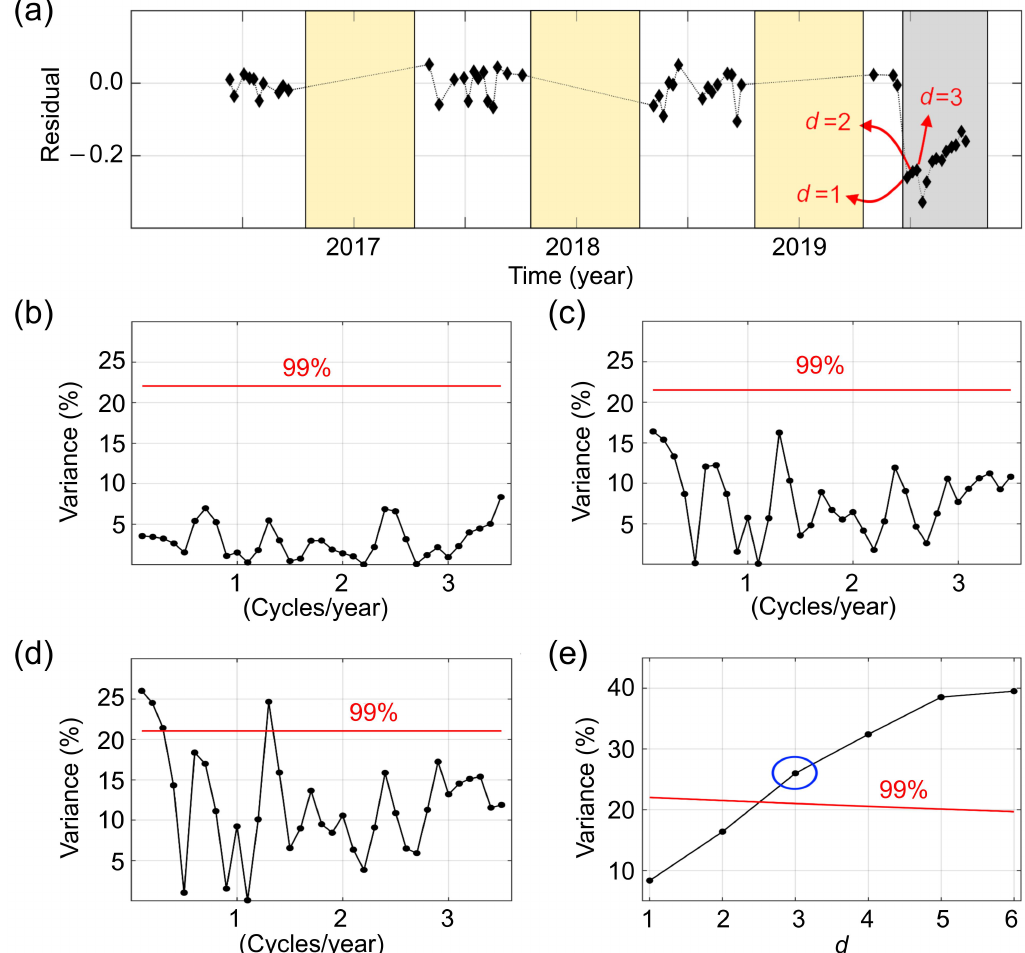
Figure 5. An example of the near-real-time disturbance detection from the residual series. ( a ) the residual series of the time series shown in Figure 4 which has an abrupt change located at the beginning of MP (gray background), ( b – d ) the weighted least-squares spectra for d = 1,2,3, respectively, with the critical values at 99% confidence level (red lines), and ( e ) the maximum percentage variance of the spectral peaks in the spectrum corresponding to each d , three of which are shown in panels ( b – d ). A disturbance is detected after three newly acquired observations, circled in panel ( e